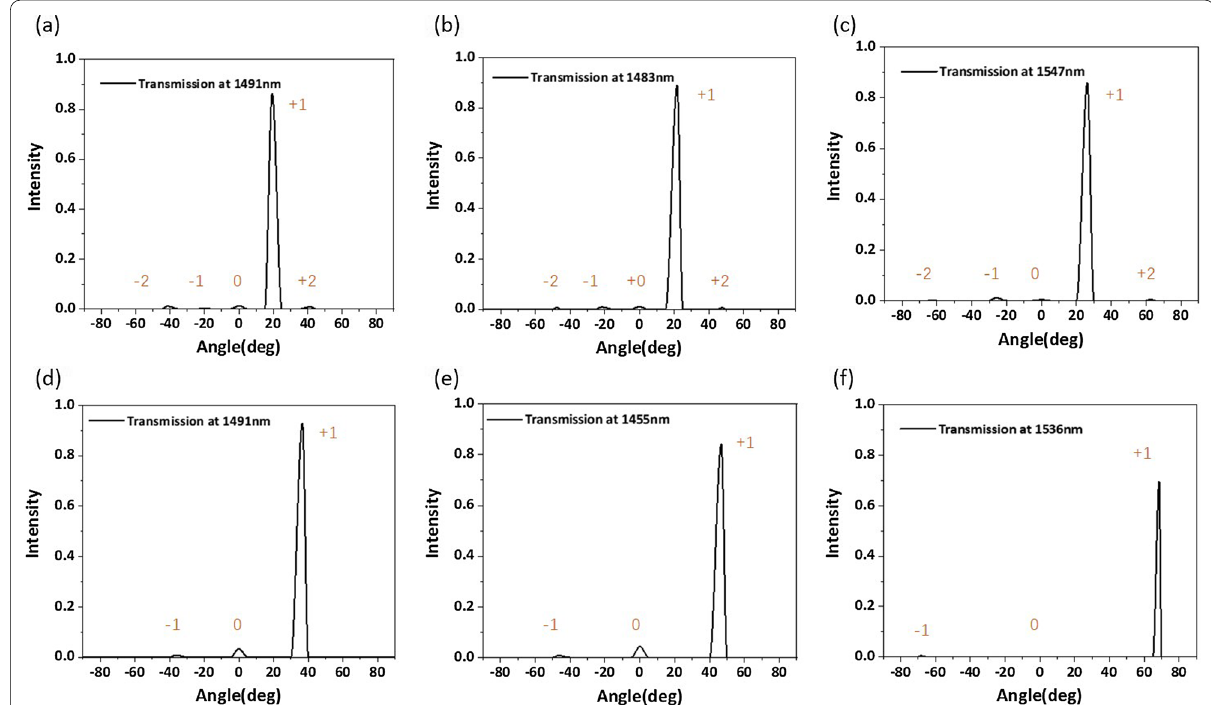
Fig. 8 Far-field transmission intensities at different angles of phase-gradient metasurfaces consisting of different element numbers. a – f represent nine, eight, seven, five, four, and three elements, respectively